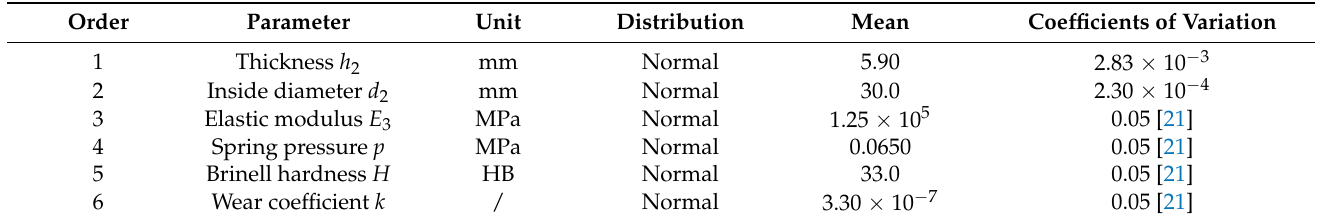
Table 4. Statistical information of the design parameters of the graphite ring.